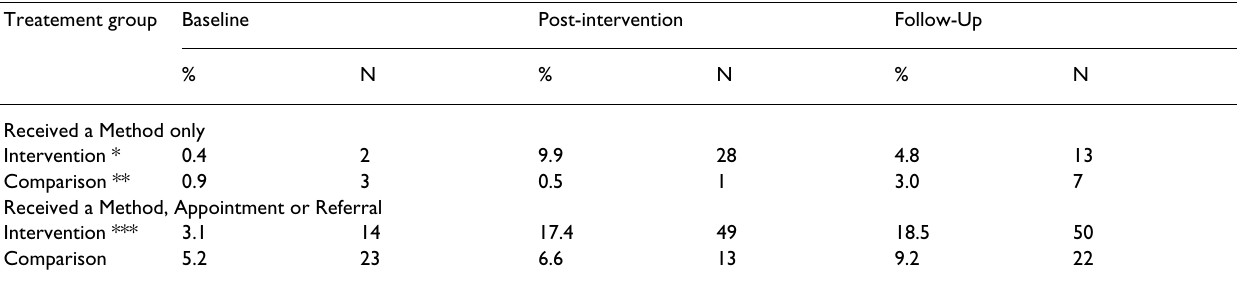
Table 5: Percentage distribution of women who reported receiving a method, appointment or referral Treatement group Baseline Post-intervention Follow-Up